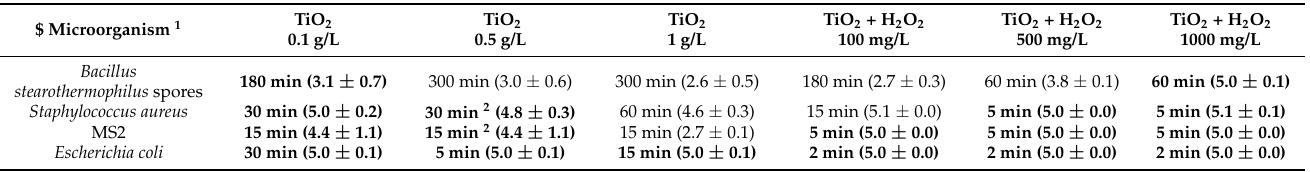
Table 1. Heterogeneous photocatalysis